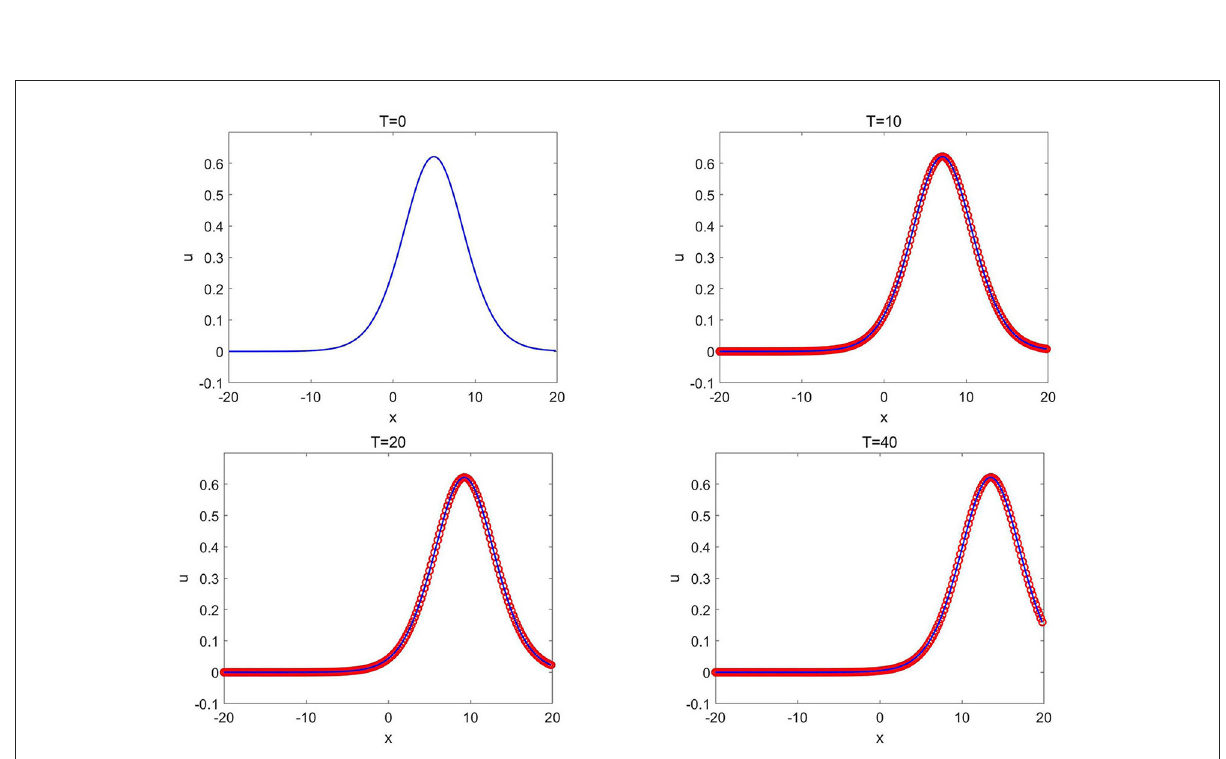
1.0 with different x 0 . =